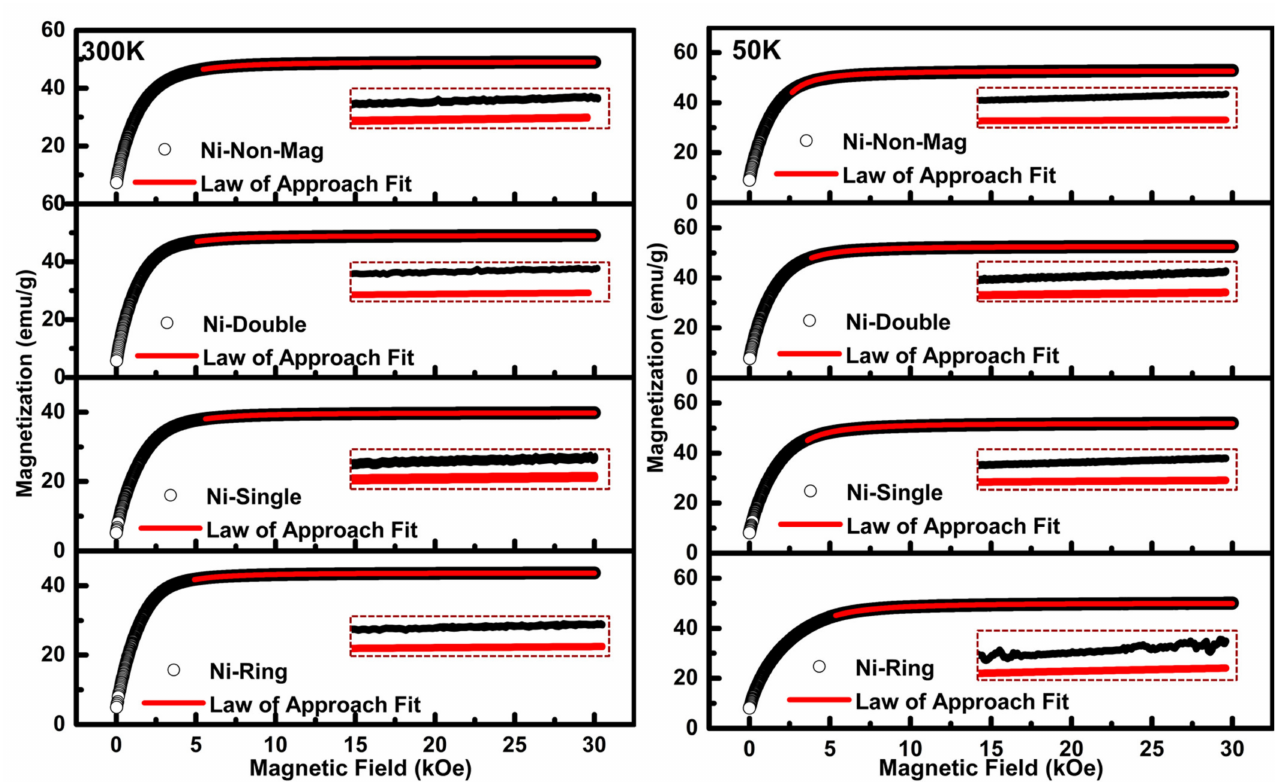
Figure 5. Law-of-approach fit of Ni-Non-Magnetic wires; Ni-Double wires; Ni-Single wires; Ni-Ring wires, using MH hysteresis curves, measured at 300 K and 50 K. The insets of the respective figures show the zoom of fit of LAS at high fields (>25,000 Oe). The experimental and fitted curve show a separation in the ranges of ~0.05–0.08 emu/g at 300 K and ~0.1–0.3 emu/g at 50 K.